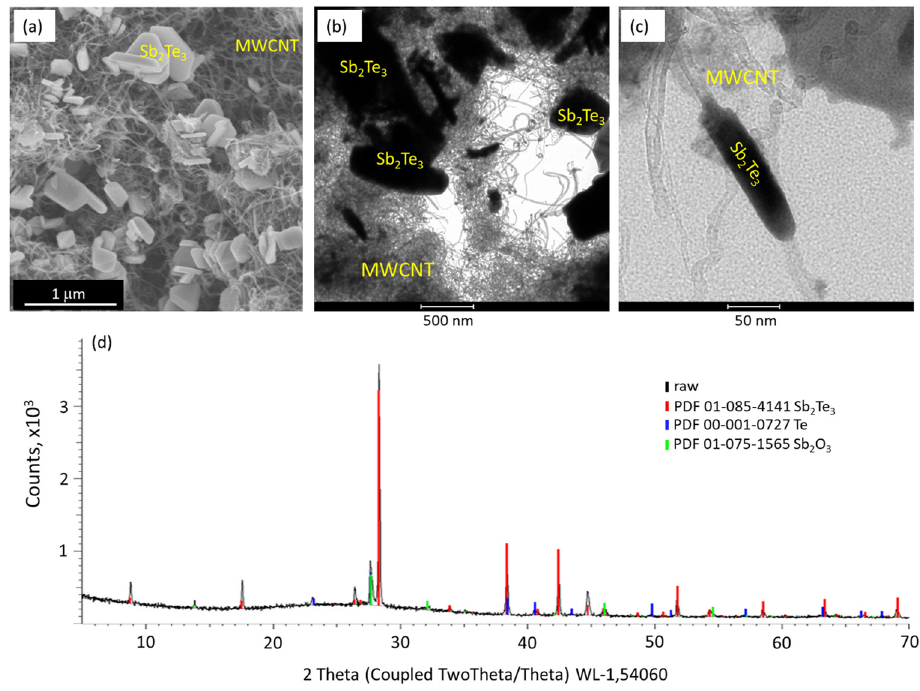
Figure 1. Scanning ( a ) and transmission electron microscope ( b , c ) images of Sb 2 Te 3 nanostructures grown on a MWCNT network via physical vapor deposition, illustrating formation of Sb 2 Te 3 clusters on the MWCNT network; ( d ) X-ray di ff raction pa tt ern of the deposited Sb 2 Te 3 nanostructures.